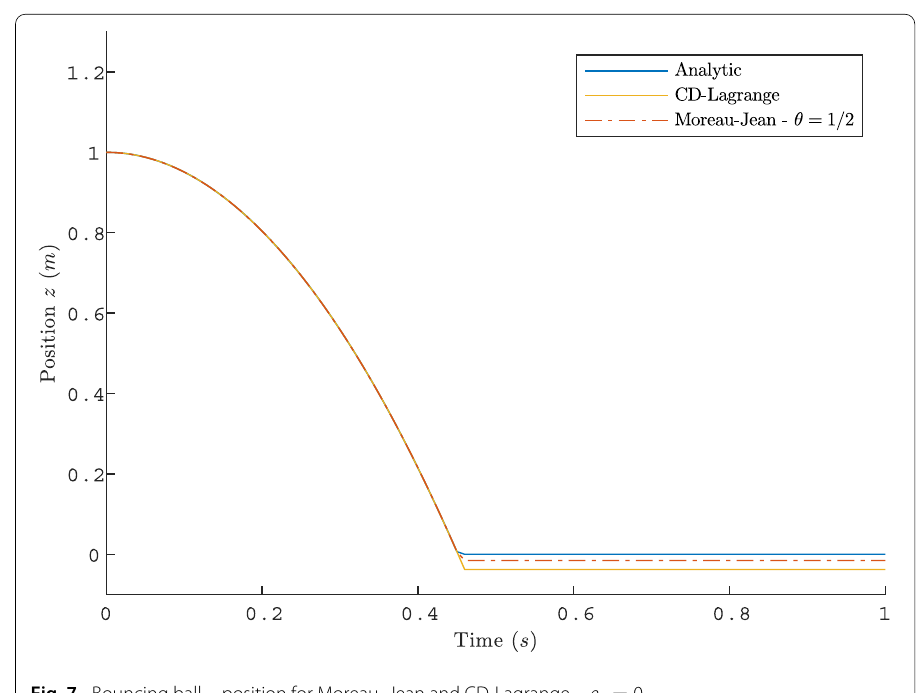
Fig. 7 Bouncing ball—position for Moreau–Jean and CD-Lagrange— e c = 0